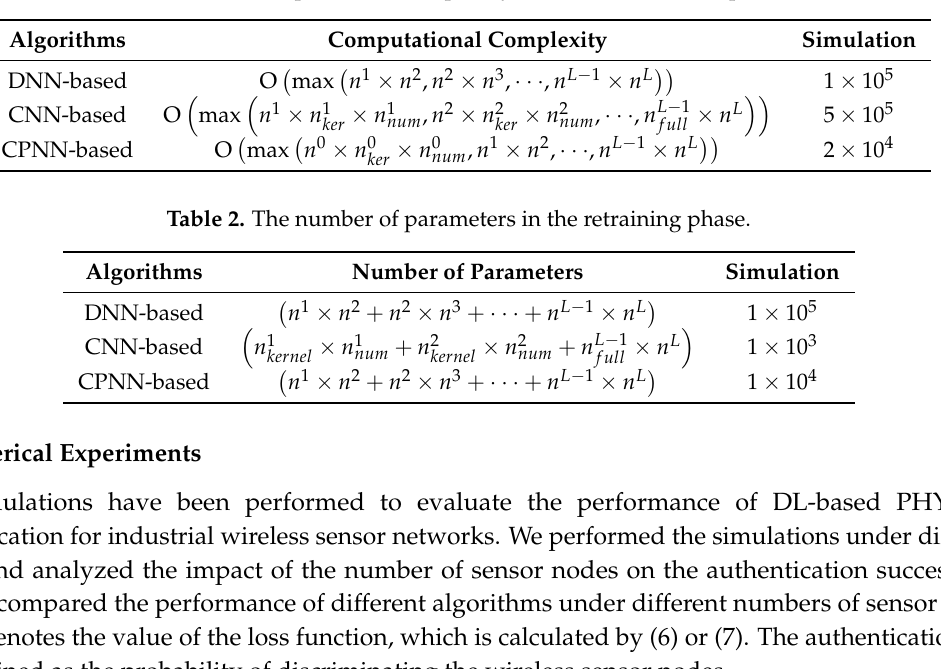
Table 1. The computational complexity in the authentication phase.